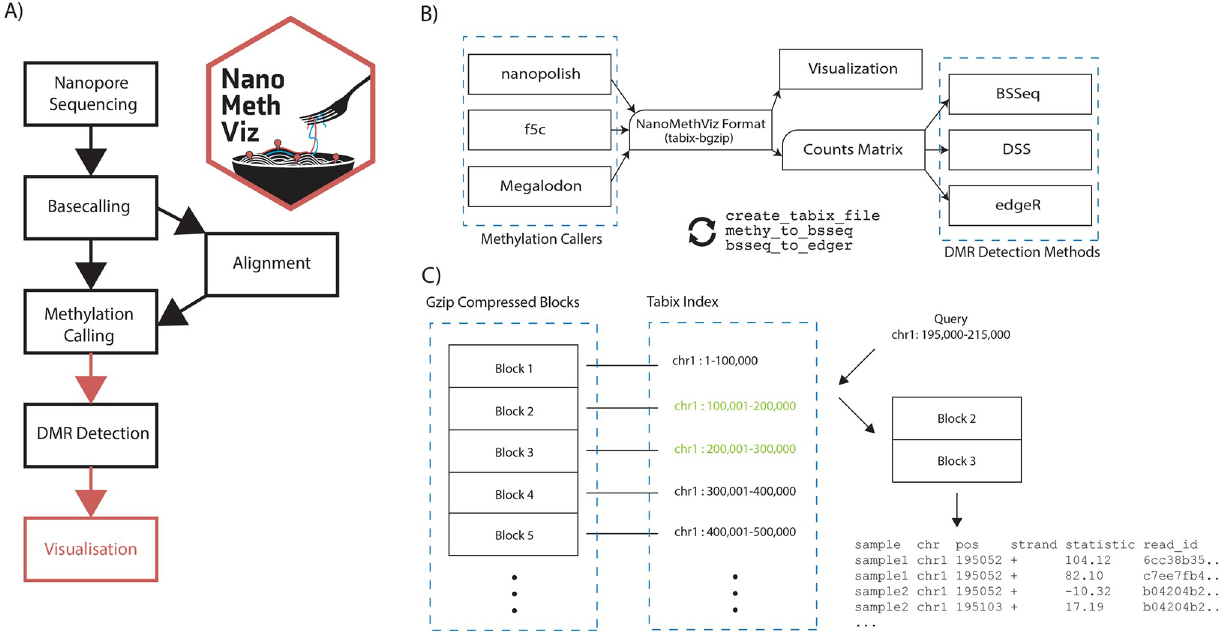
Fig 1. Nanopore methylation workflow and data format. A) The workflow used to perform differential methylation analysis. The red arrows indicate steps where further NanoMethViz provides conversion functions to bridge workflow steps. NanoMethViz performs visualization at the end of the workflow. B) Functions are provided in NanoMethViz to import the output of various methylation callers into a format used for visualization. This can be further converted by provided functions into formats suitable for various DMR detection methods provided in Bioconductor. C) The bgzip-tabix format compresses rows of tabular genomic information into blocks, and indexes the blocks with the range of genomic positions contained. This index is used for fast access the relevant blocks for decompression and reading.